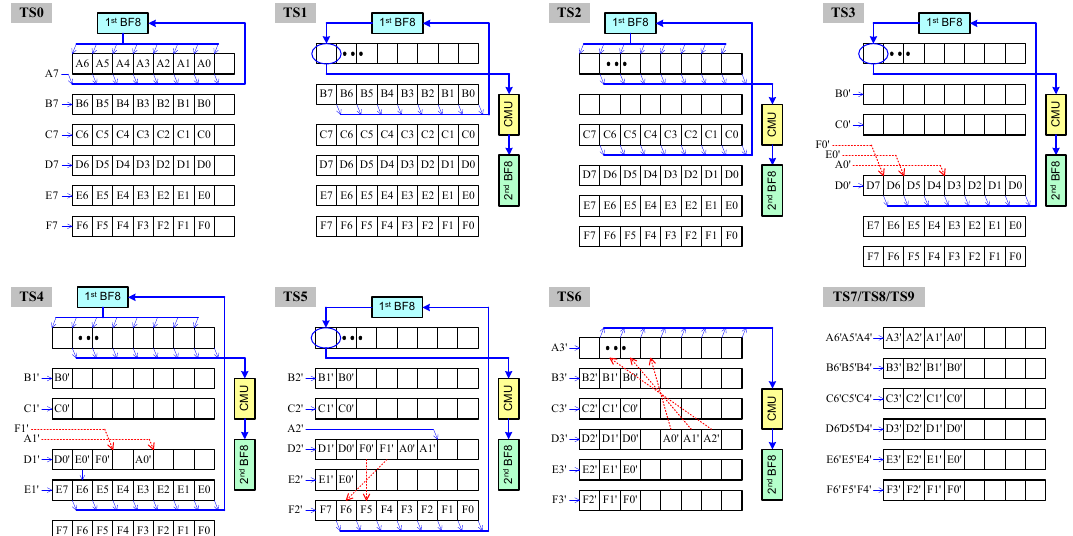
Figure 11. Block diagram of Module 2 (sorting buffer).